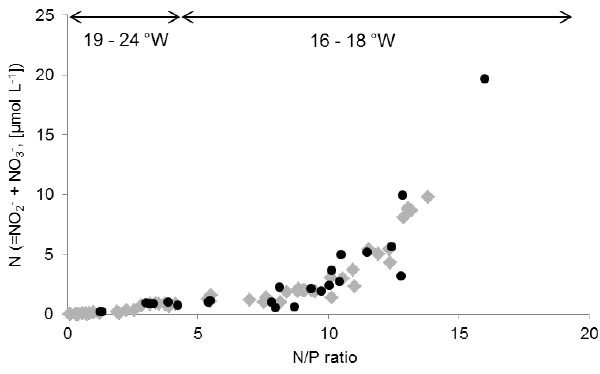
Fig. 4. Nitrogen (N = nitrate and nitrite) vs. N:P ratios in surface water (5m (grey diamonds) and 10 to 30m (black dots)). P stands for dissolved